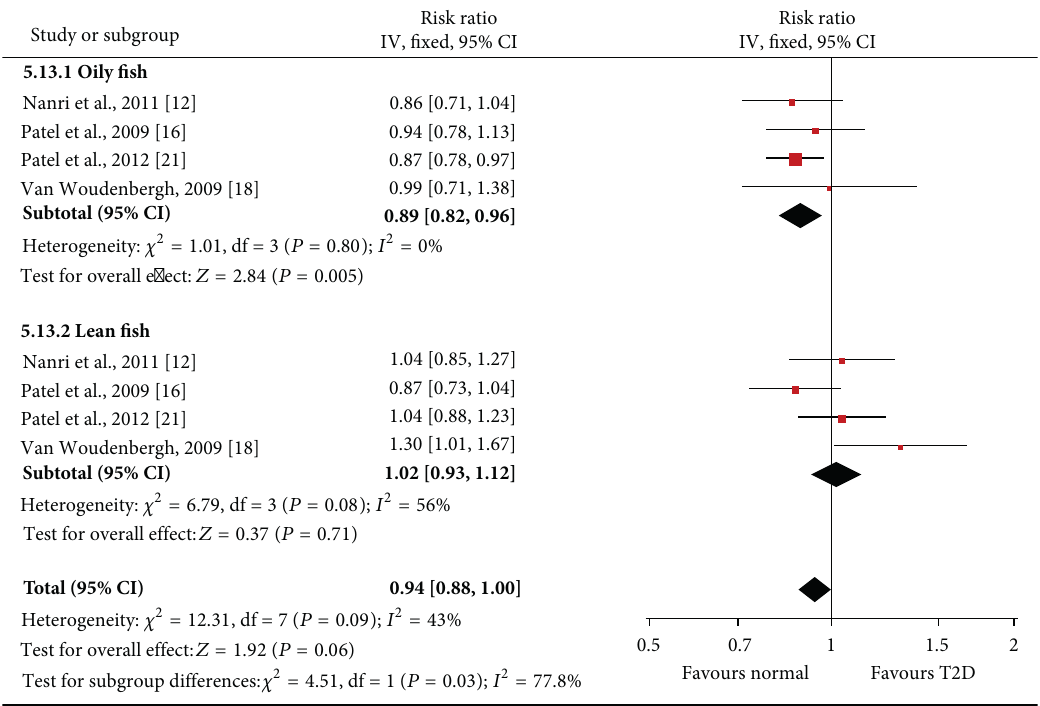
Figure 3: Forest plot of the meta-analysis for oily fish and lean fish intake and incidence of type 2 diabetes.